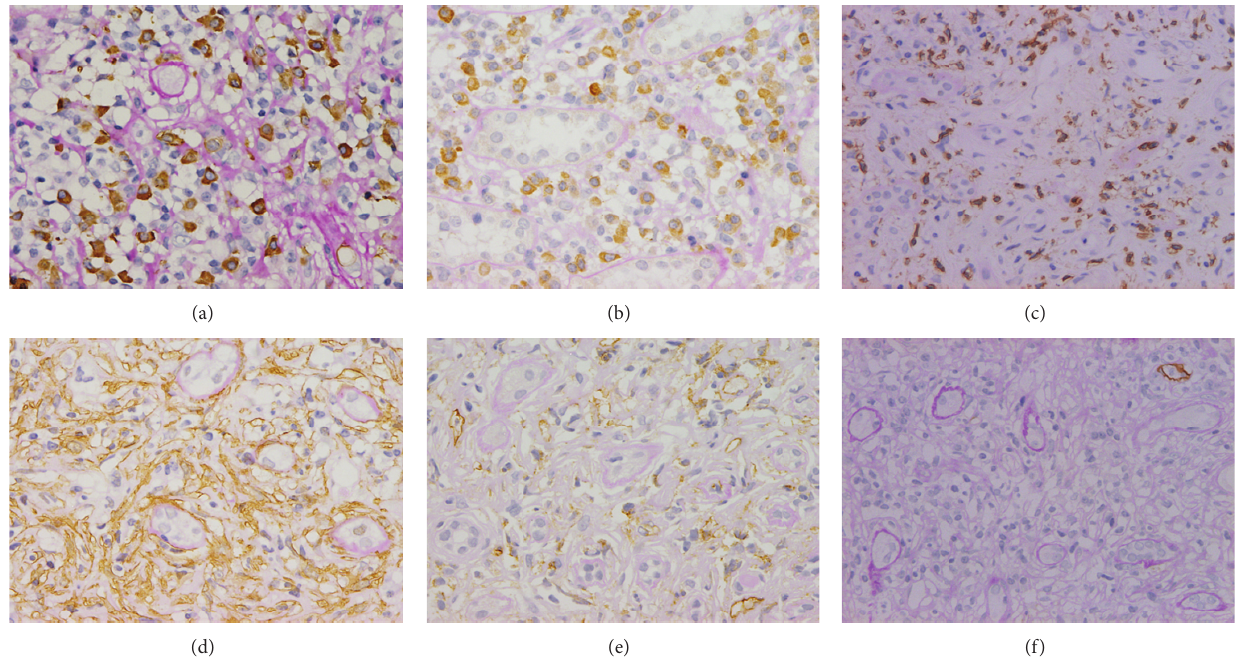
Figure4:RetrospectiveimmunostainingofthefirstrenalbiopsytissuerevealedhighnumbersofIgG4-positiveplasmacellsintheinterstitium ((a), ×400 ). Many CD79a-positive B cells ((b), ×400 ), CD45RO-positive T cells ((c), ×200 ), and alpha-SMA-positive activated fibroblasts were also observed in the interstitium ((d), ×400 ). Large numbers of CD31-positive PTC ((e), ×400 ) and few D2-40-positive lymphatic vessels ((f), ×200 ) were